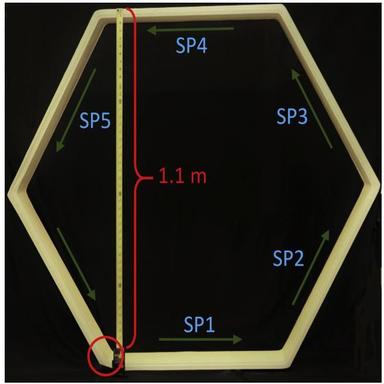
Image of the printed hexagon showing the location of each specimen, arrows indicate build direction, and circle specifies seam edge.